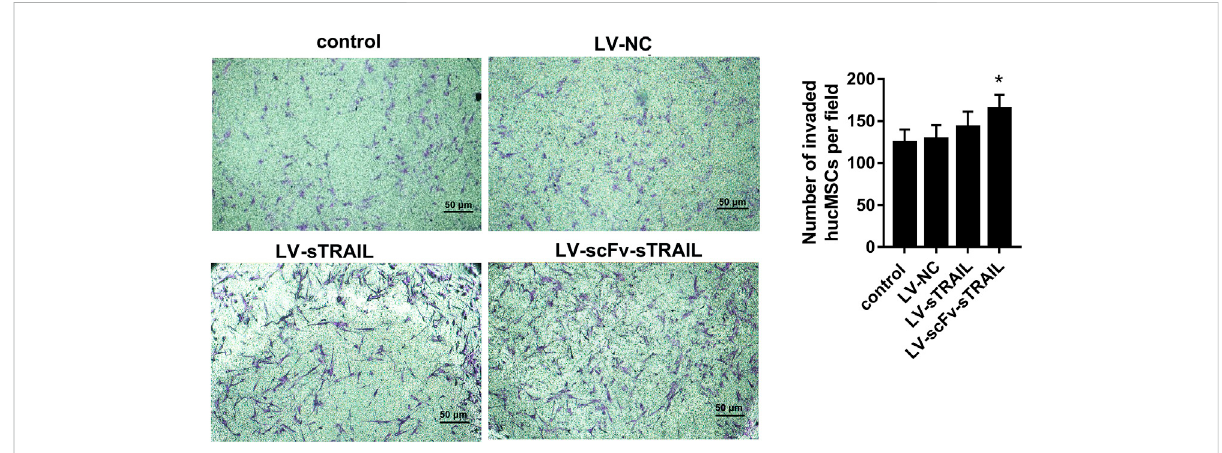
FIGURE 4 TheeffectofLV-scFv-sTRAILinfectiononhucMSCstropismtowardU87Gdetectedbythetranswellassay(×100).Scalebar=50 μ m n =3,* p < 0.05 versus the LV-NC